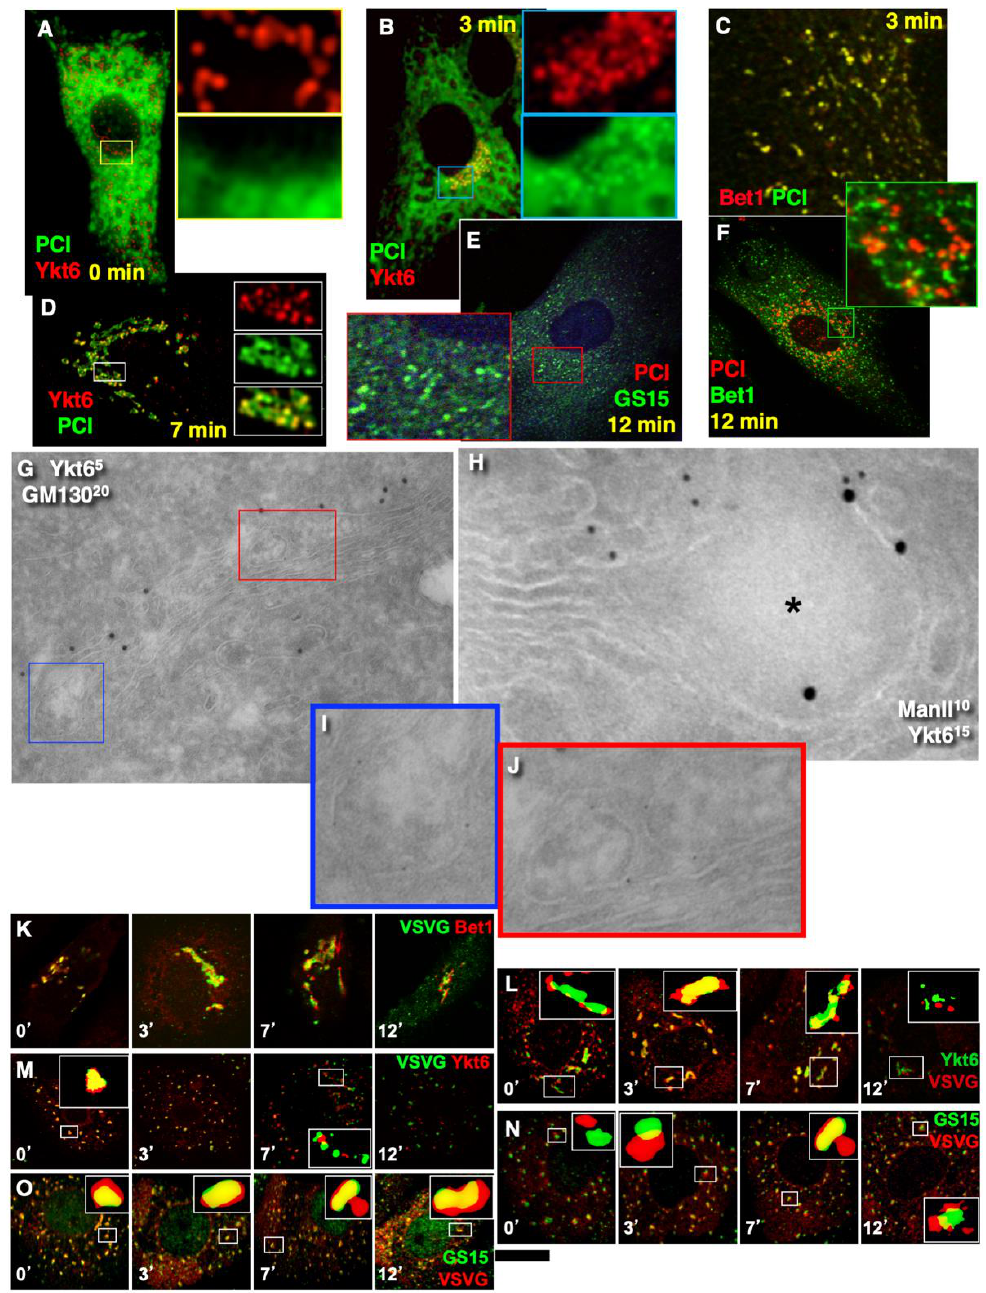
Figure 10. Enrichment of SNAREs in membranes surrounding the cargo domains. ( A – J ) Human fibroblasts. ( K – O ) HeLa cells. ( A – F , K – O ) Fluorescence microscopy. ( G – J ) Tokuyasu cryo-sections. ( A – O ) Mini-wave. ( A ) Before the release of the transport block, Ykt6 was a little enriched at ER exit sites. ( B ) At 3 min after the release of the transport block, PCI formed dots where Yklt6 became enriched. ( C ) PCI dots co-localised with Bet1. ( D ) At 7 min after re-initiation of intra-Golgi transport, PCI and Ykt6 dots were co-localised. ( E , F ) At 12 min after re-initiation of intra-Golgi transport, PCI dots lost their co-localisation with Ykt6 and Bet1 but acquired co-localisation with GS15. ( G – J ) En- richment of Ykt6 in membranes surrounding PCI distensions (blue, red boxes). ( I , J ) Enlargement of areas inside the blue and red boxes in ( G ). ( K , L ) VSVG-containing dots acquired Bet1, then Ykt6, and finally GS15, whereas Bet1 disappeared in these dots. ( M – P ) Fluorescence microscopy. Ministacks (pre-treatment of cells with 33 µM nocodazole for 3 h). Times of IGT are indicated on images (( K – O ); quantified in Figure 2N,O). Scale bars: 4 µm ( A – F , K – P ); 130 nm ( G ); 90 nm ( H ).